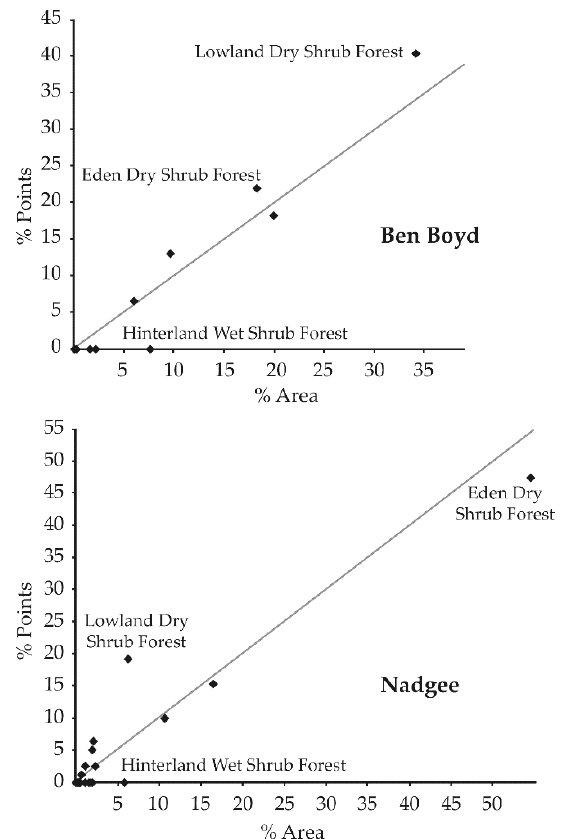
Figure 3. Distribution of camera-trap survey sites in relation to major vegetation classes across the study area. Vegetation classes proportionately under-sampled by initial desktop site allocation (indicated by written captions) were addressed in the field by re-allocating site locations.